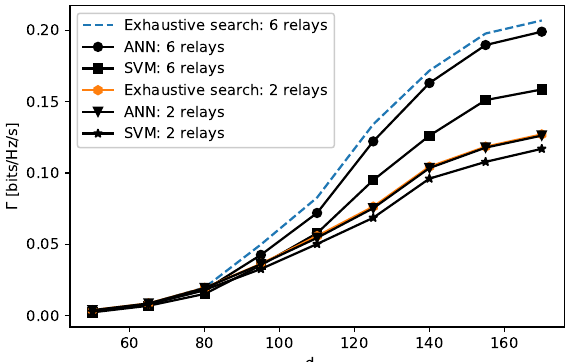
Figure 6. Comparison of performance of ANN method with SVM